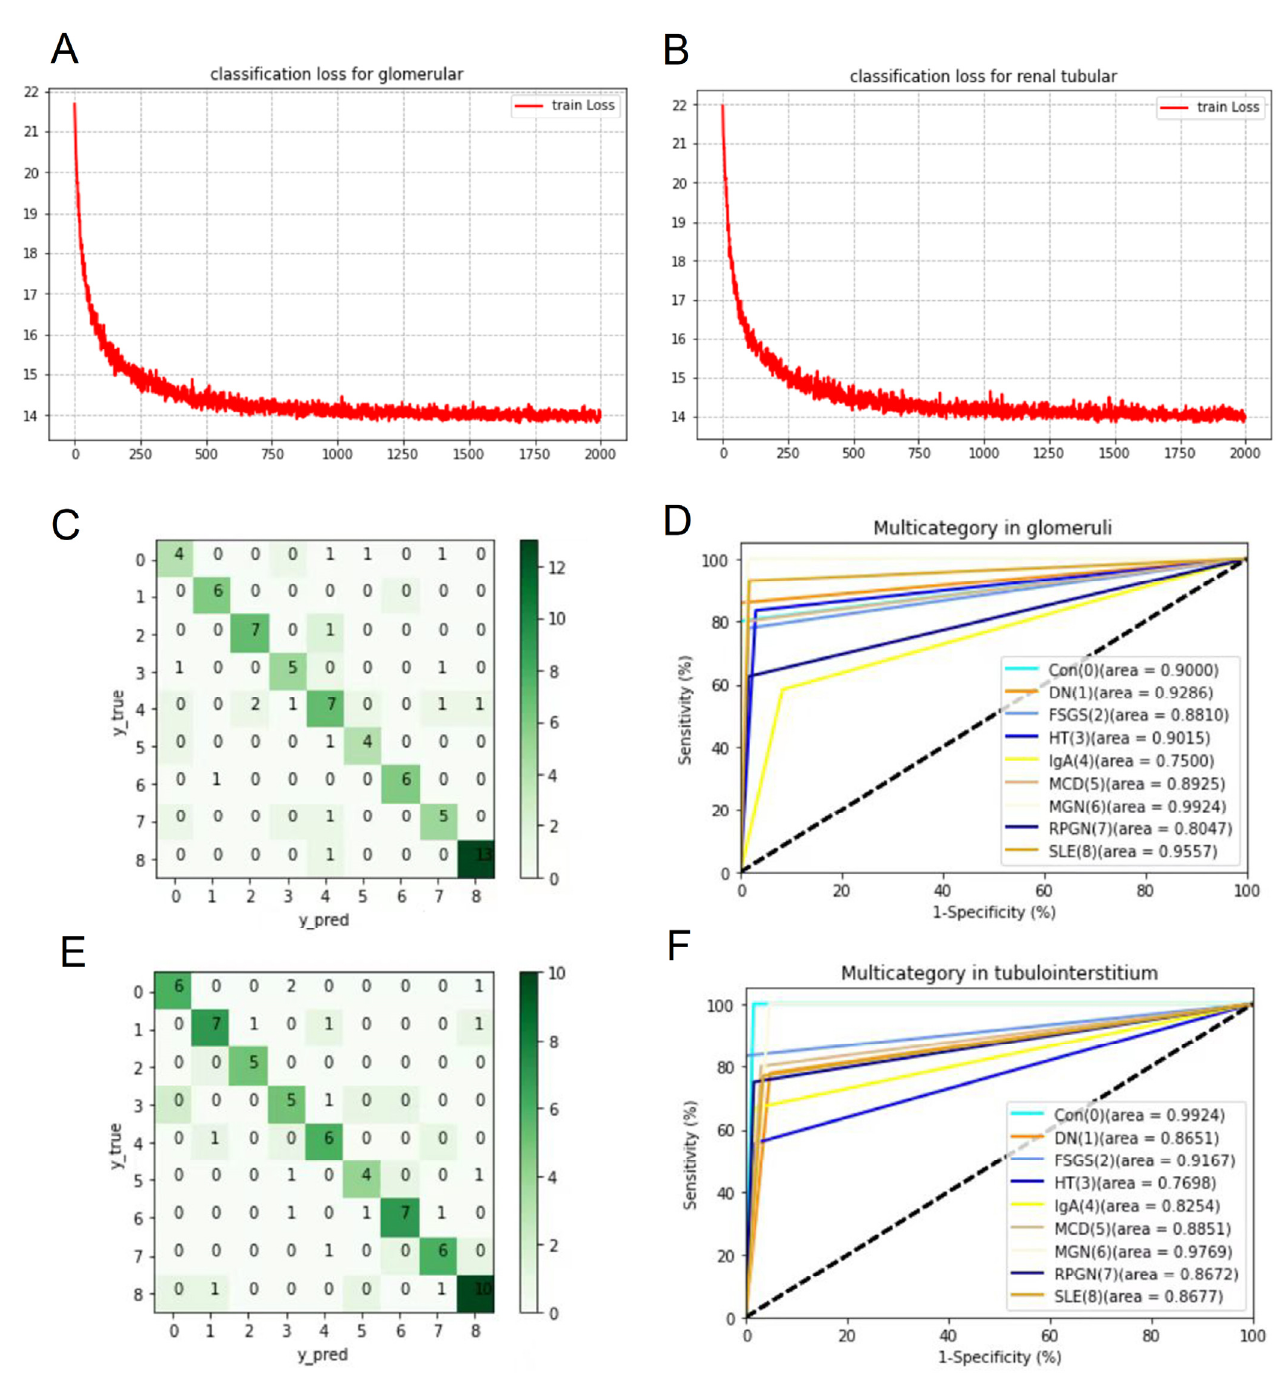
Figure 8. The loss curves, confusion matrix, and ROC curves of deep learning. ( A ) The loss curve of 274 candidate DIRGs based on data 1. ( B ) The loss curve of 274 candidate DIRGs based on data 2. ( C ) The confusion matrix of 274 candidate DIRGs based on data 1. ( D ) ROC curves of characteristic genes for each GN subtype in data 1. ( E ) The confusion matrix of 274 candidate DIRGs based on data 2. ( F ) ROC curves of characteristic genes for each GN subtype in data 2.